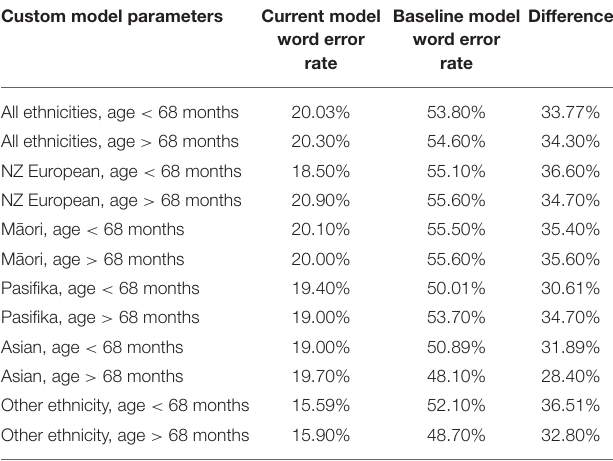
TABLE 3 | Word error rate for custom models compared to baseline model. Custom model